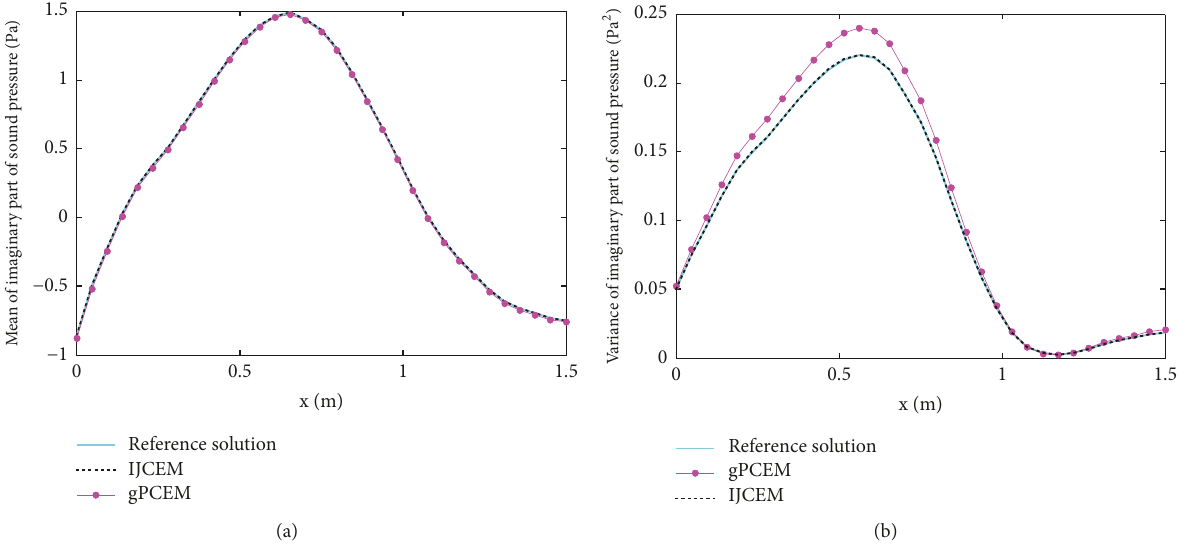
Figure 8: Mean and variance of sound pressure of car along the bottom boundary at f=100Hz: (a) mean and (b) variance.